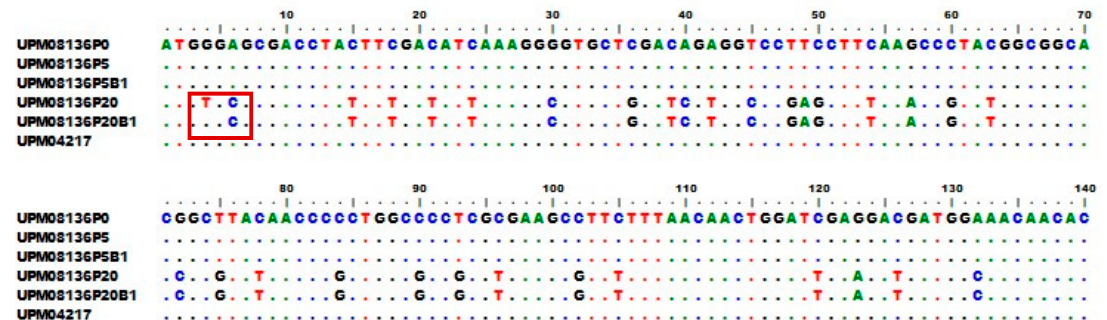
Figure 5. Multisequence alignment comparing the hexon gene nucleotide sequences of original, flask, and bioreactor propagated isolates of UPM08136 and UPM04217 reference isolate from Genebank. There was a point substitution from T to G at position 4 between bioreactor UPM08136CELP20B1 and flask UPM08136CELP20 (red box). There was no change between UPM08136CELP5B1 and UPM08136CELP5.